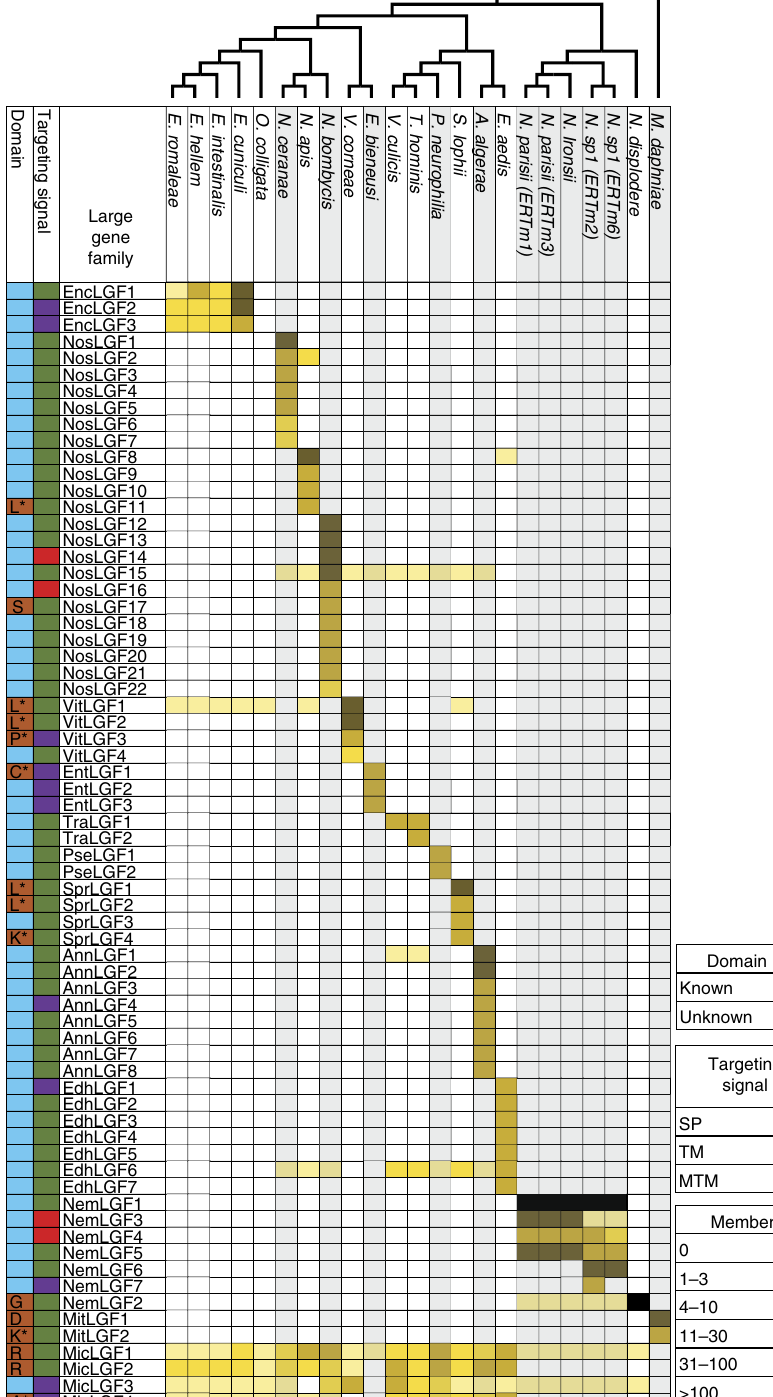
Figure 4 | Large gene families are widespread throughout microsporidia. Heat map showing large gene families identified in microsporidia and the number of gene family members in each species. Cladogram of species is shown at the top. Each column represents a species and strains are shown in parentheses. Each clade of species is alternatively shaded in grey or white. Each row represents a large gene family. Families are named and clustered based on the genus from where they were identified. The first column indicates if a known Pfam domain can be found within the indicated large gene family. Domains defined as follows: L (LRR), S (serpin), P (peptidase M48), C (chitin synthase), K (kinase), D (Duf3638), R (RicinB) and A (ABC transporter). Members of each gene family were determined using HMMER, except for those indicated with an *, which were determined using OrthoMCL. The second column indicates the targeting signal that is overrepresented within the indicated gene family. SP, signal peptide, TM, single transmembrane domain and MTM, multitransmembrane domain. Each box in columns to the right of the gene family name is coloured according to the total number of members within a given gene